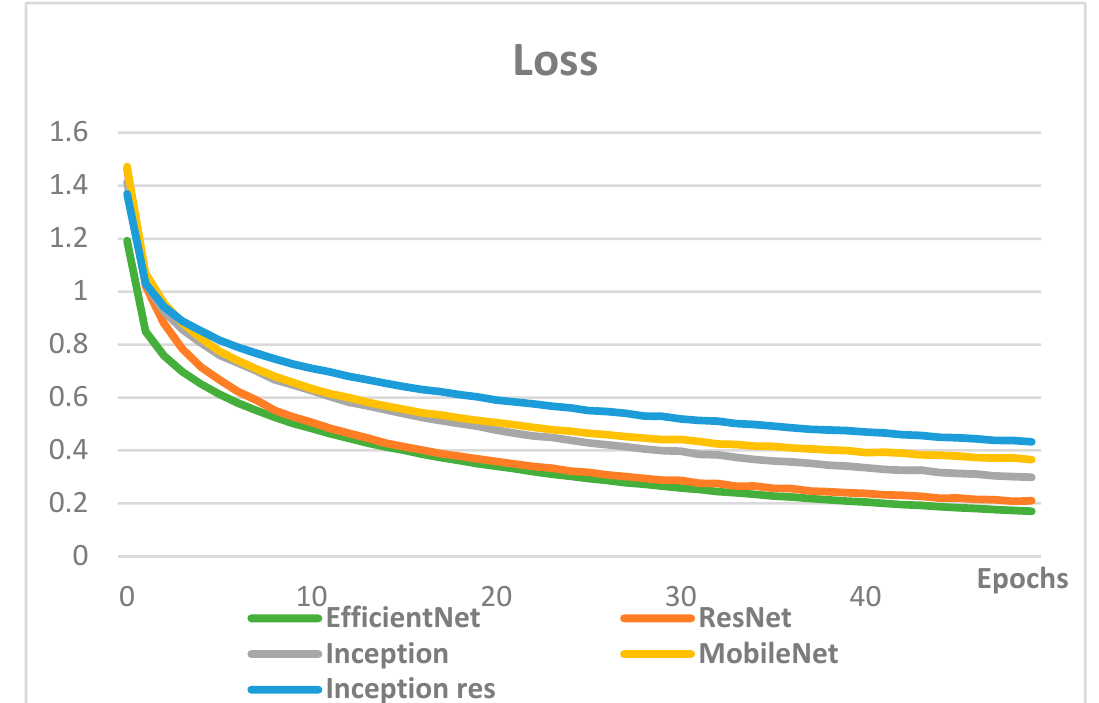
Figure 8. Loss comparison of the CNN-based models.